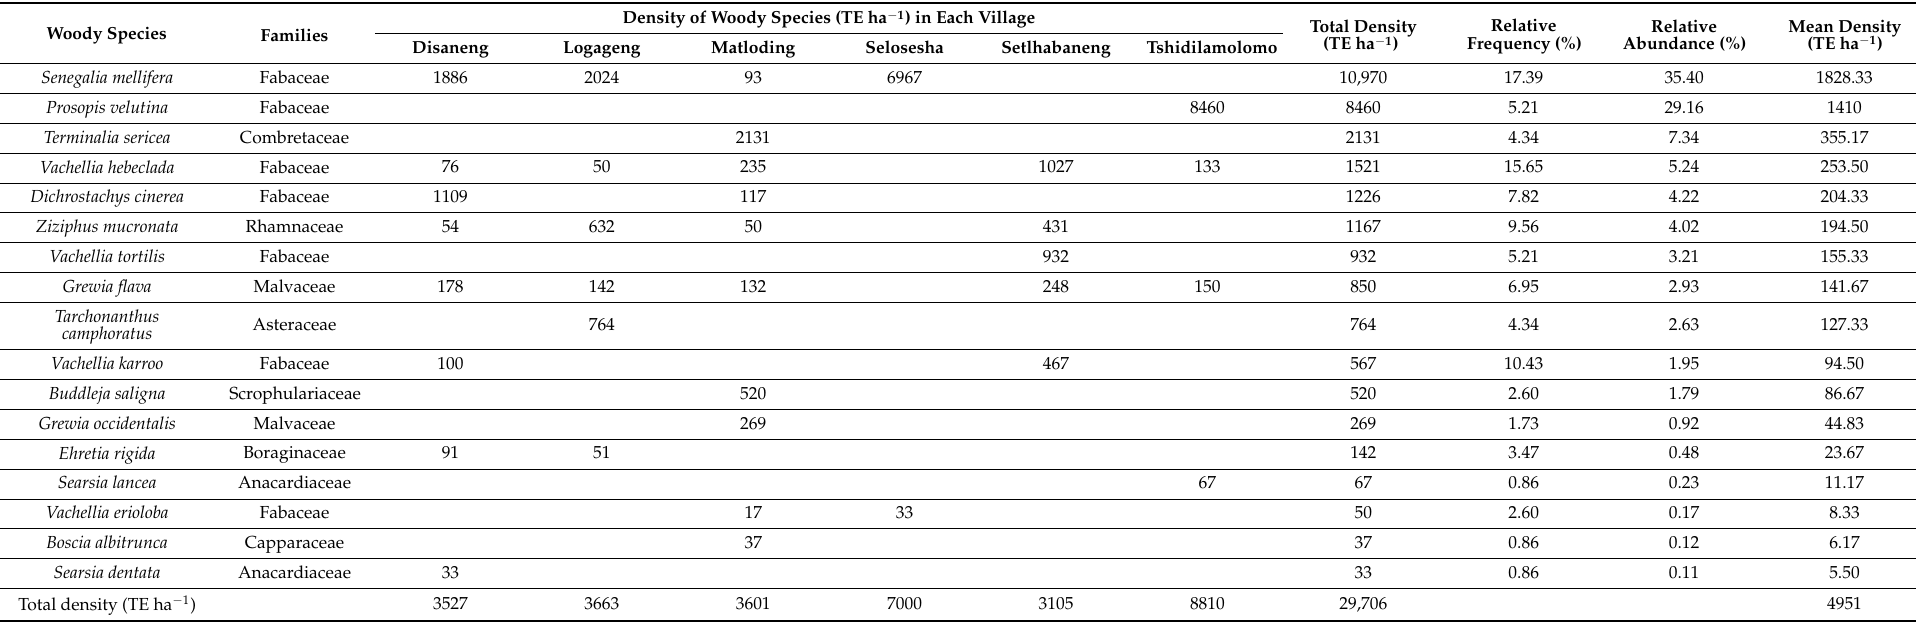
Table 1. Overview of woody species density of all sampling sites (n = 30) in decreasing order of mean density of each